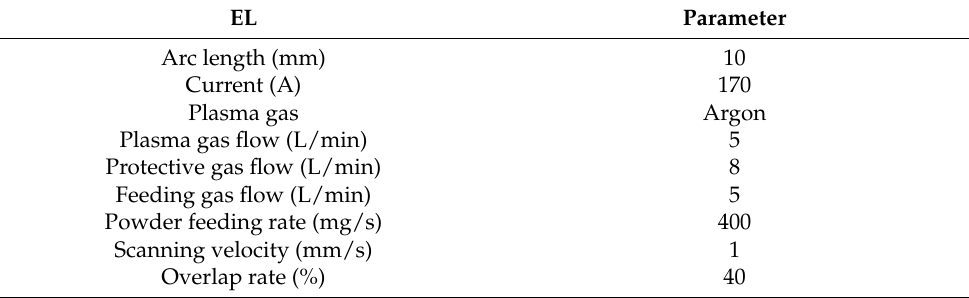
Table 1. Experimental process